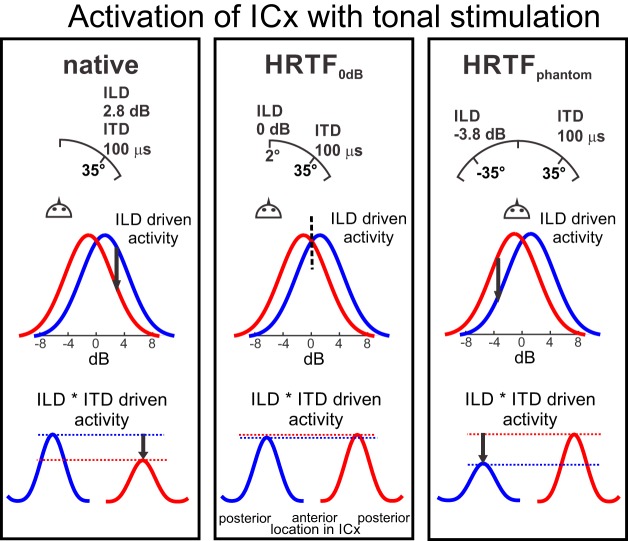
Behavioral data explained by rival brain hemispheres. ILD and ITD form a map of auditory space and interact by multiplication. The figure shows the possible influence of ILD on the ITD-driven activity in both midbrain hemispheres with tonal stimulation as example. Left column, When ILD and ITD point at the same direction, as it is the case with native stimuli, ILD-driven activity is higher in the left brain side corresponding to the true source (blue) than in the right side that corresponds to the phantom source (red). This reflects on the overall activity (lower row). Hence, the owl localizes the true source more often than the phantom source. More frontal ITDs are represented in the anterior ICX, while peripheral ITDs are found in posterior parts of the ICX. Middle column, If the ILD is fixed to 0 dB, the ILD-driven activity in both brain sides is almost equal and, thus, the overall activity, too. The owl then localizes phantom and true sources with the same frequency. Right column, If the ILD is fixed to the value that corresponds to the phantom source, the overall activity is higher in the brain side that corresponds to the phantom source (right brain side for phantoms in the left hemifield). Consequently, the owls turned their head more often to the phantom source.